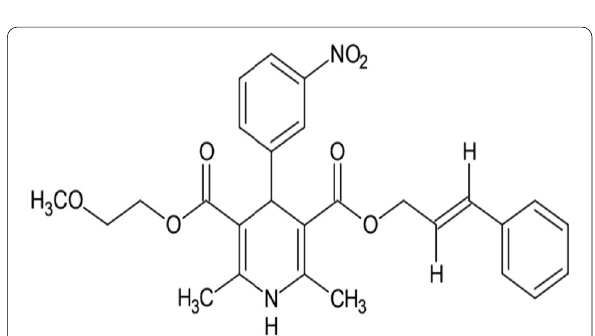
Fig. 2 Chemical Structure of Cilnidipine